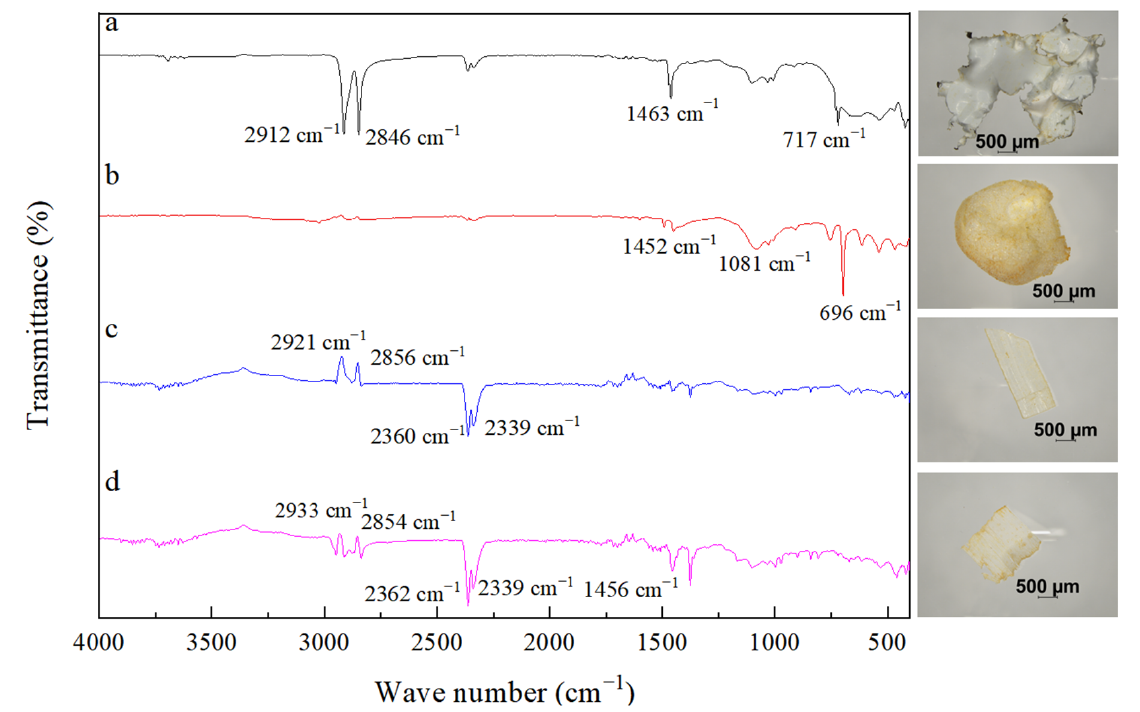
Figure 5. Typical identified microplastics and their compositions. Polyethylene ( a ), polystyrene ( b ), polyvinyl chloride resin ( c ), polypropylene ( d ).